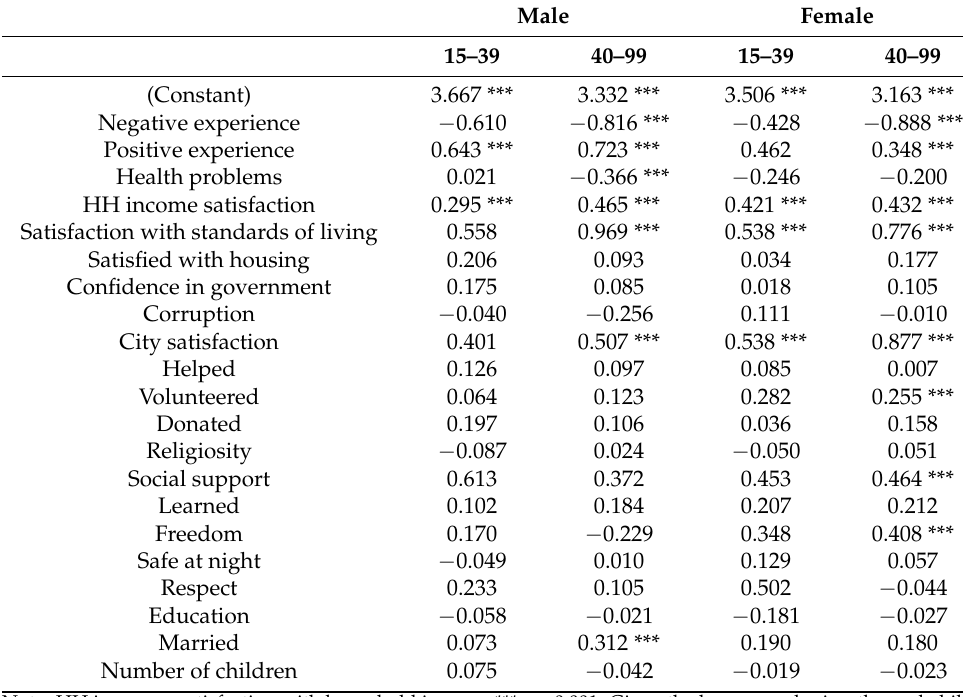
Table 3. Unstandardised Regression Coefficients for Age and Gender